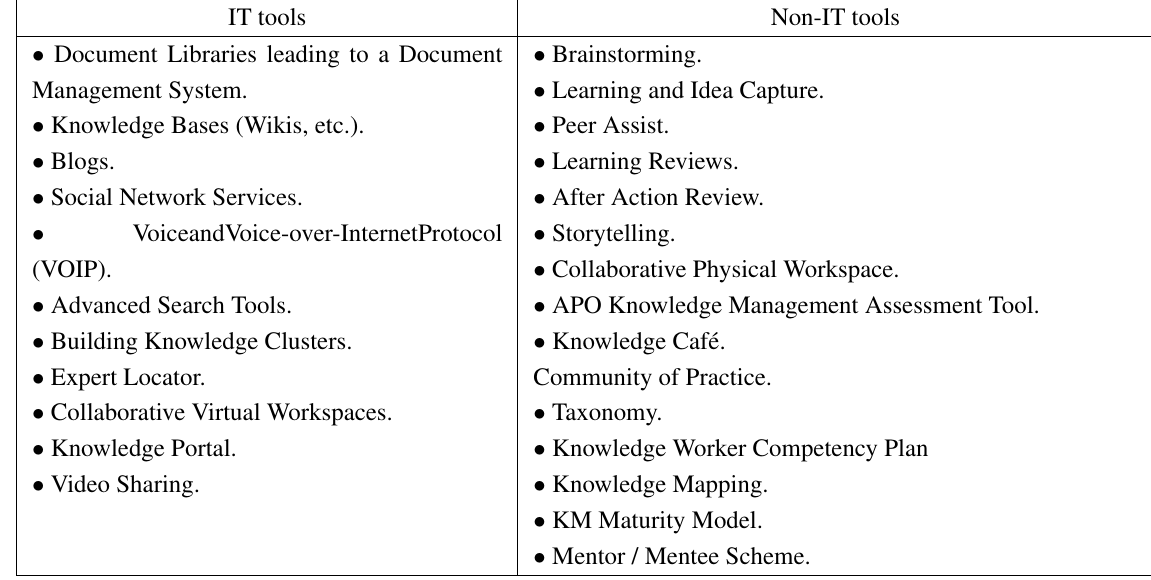
Table 7. IT tools and Non-IT tools of